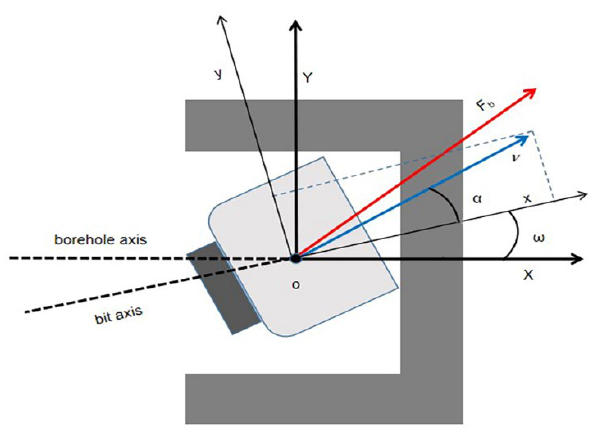
Figure 5. Digram of drilling trend